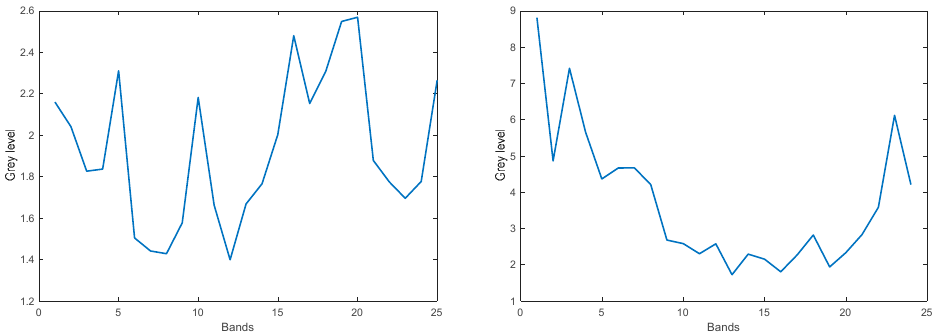
Figure 4. Variance of sensor noise which depends on the gray level, after vignetting correction, average gray level = 124. Left : for the 25 original bands. Right : the 24 virtual bands.